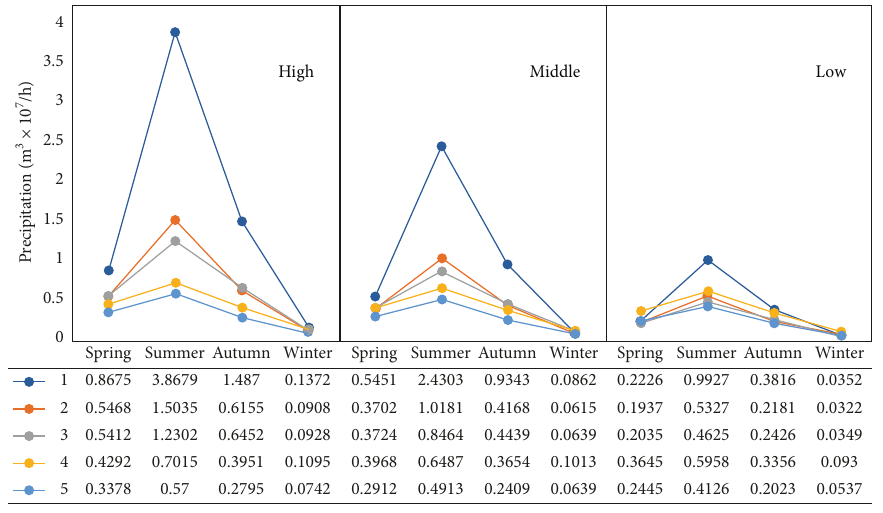
Figure 7: High, middle, low-level precipitation in each seasonal stage of each hydropower station candidate.